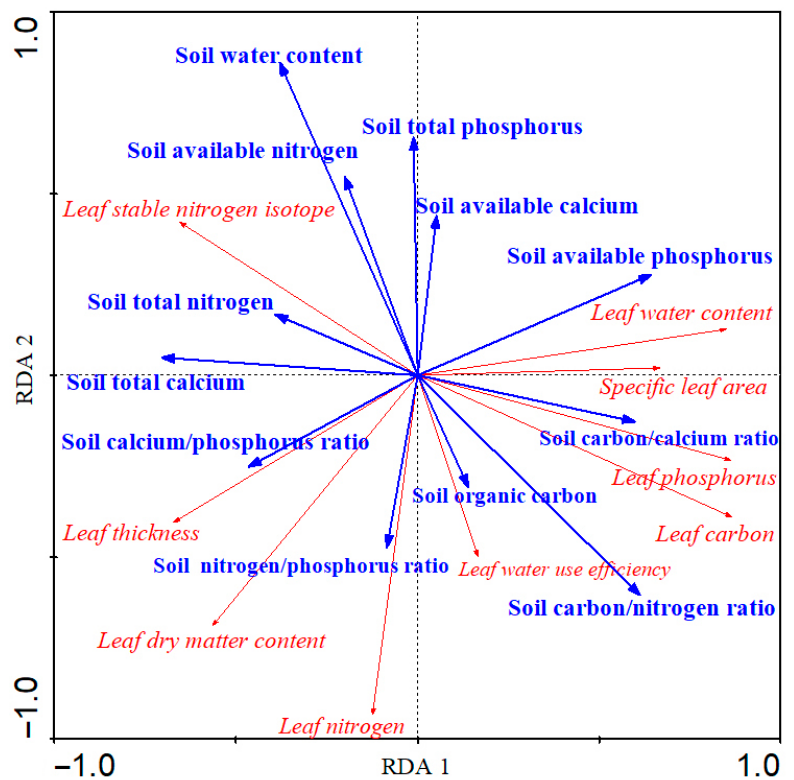
Figure 4. Redundancy analysis of the relationship between leaf functional traits of Z. planispinum ‘dintanensis’ and soil factors.